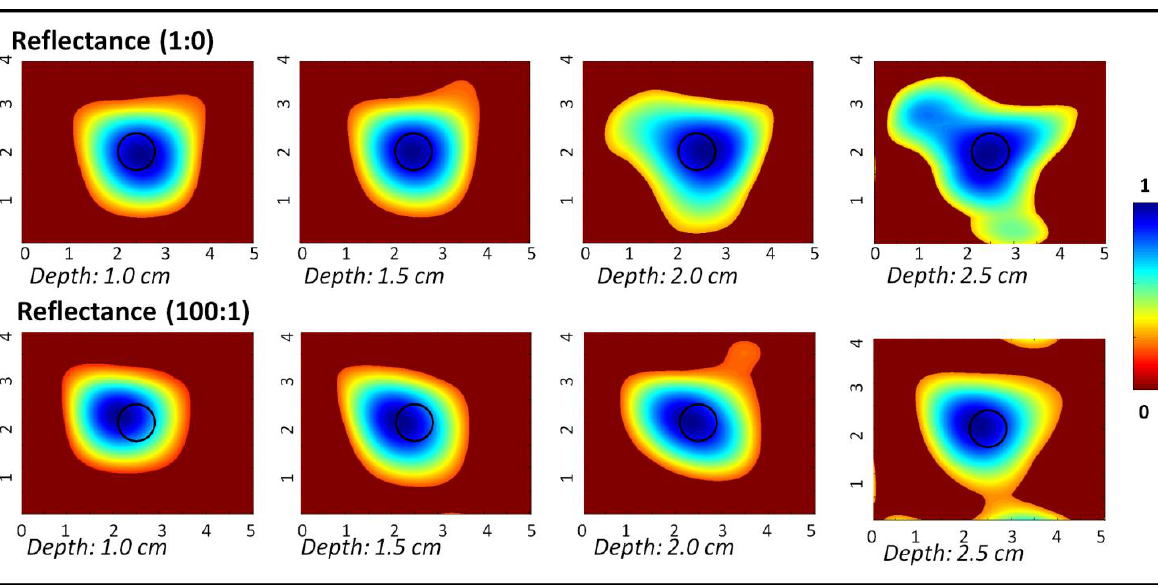
Figure 4. Two-dimensional surface contour plots (via 5th degree polynomial fit) of reflectance imaging studies of a 0.45 cc spherical target at 1:0 and 100:1 T:B India Ink contrast, located at various depths. The black hollow circle represents the true 2D target location.